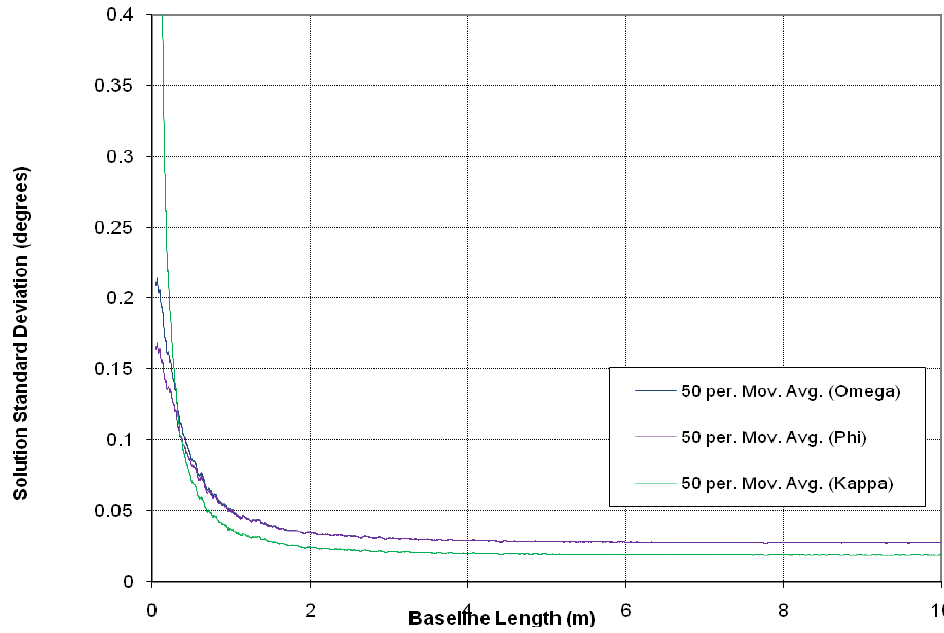
Figure 8. Simulation Results of the Dual-Antenna Case showing precision of calculated orientation angles vs. mounting bar length for systematic ten device stops; the curve's actual dampening happens again at about 1 m bar length; it can be noticed that the achieved accuracy at the 1 m bar length value with ten device stops is better than what is required for stationary